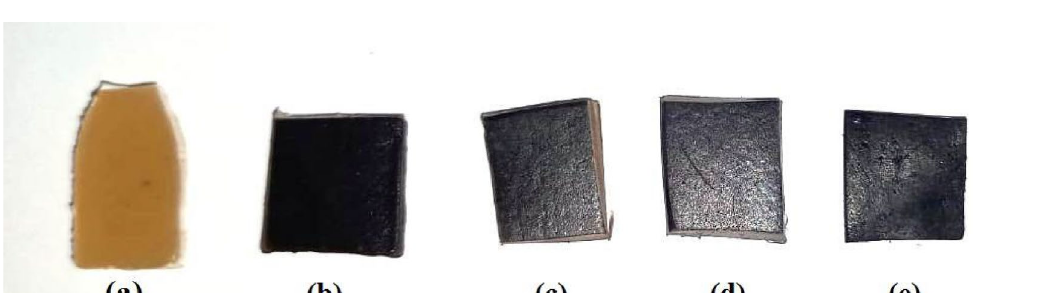
Figure 3. proposed amine-functionalized poly (vinylchloride/Linear low-density polyethylene)/ZnO with the selected different four amines; ( a ) ethylene diamine EDA, ( c ) aniline An, ( d ) p-anisidine pA, ( e ) N, N dimethyl aniline DMA and ( b ) a possible crosslinking mechanism for two products functionalized by diamine precursors. The photo in bottom is show the changing of samples color after amination reaction ( a ) (PVC/LLDPE)ZnO-b, ( b ) (PVC/LLDPE)ZnO-EDA, ( c ) (PVC/LLDPE)ZnO-An ( d ) (PVC/LLDPE)ZnO-pA and ( e ) (PVC/LLDPE)